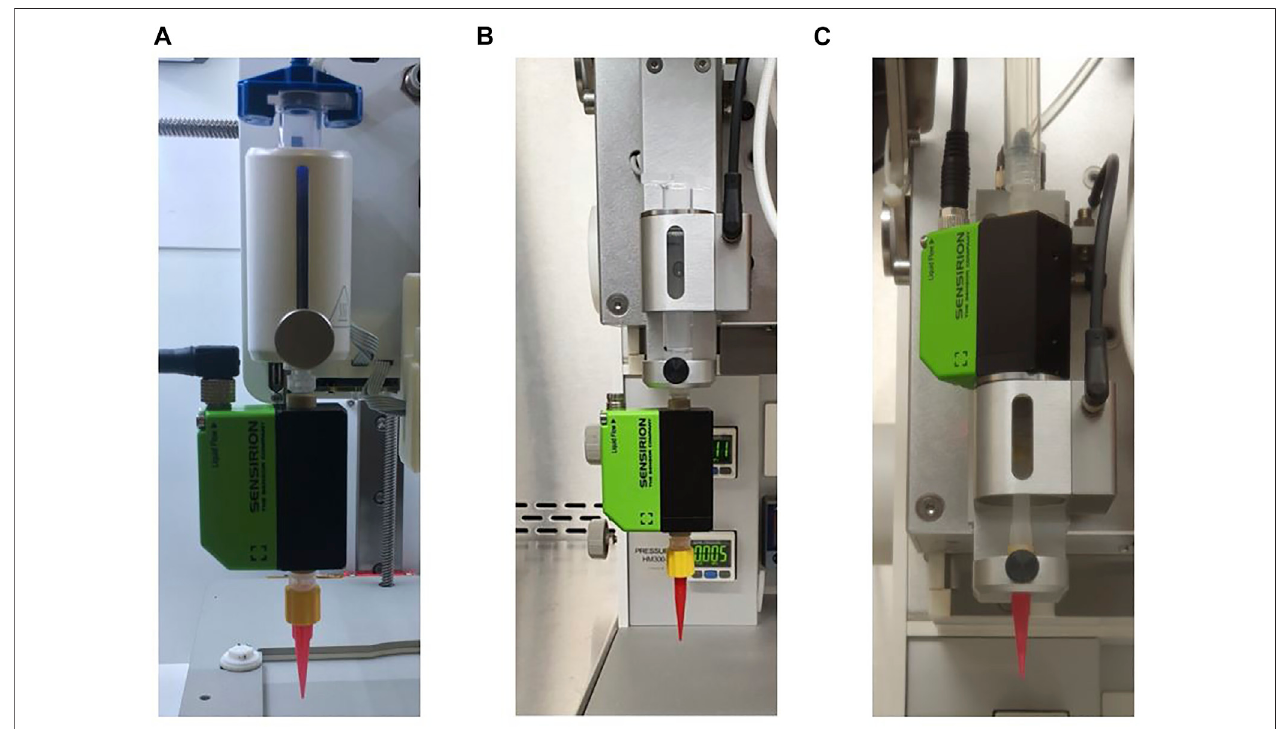
FIGURE 2 | Different incorporation setups for the fl ow sensor into the bioprinters. For the investigation of cartridge fi lling level in fl uence it was attached to BIOX as shown in (A) and to 3D Discovery ™ as shown in (B) . The reprodicibility experiments were only performed with the 3D Discovery ™ and a different attachment of the sensor depictured in (C) .